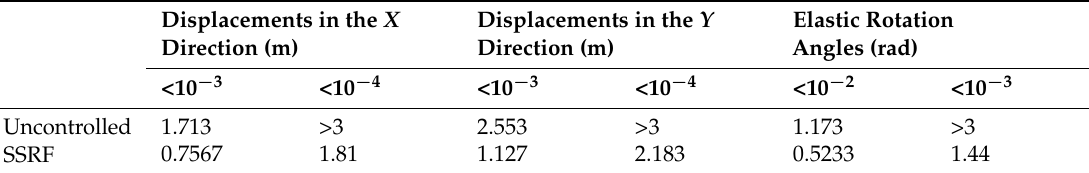
Figure 11. Elastic rotation angles of the moving platform in the XY plane. Table 2. Data concerning the consumption of time (s).